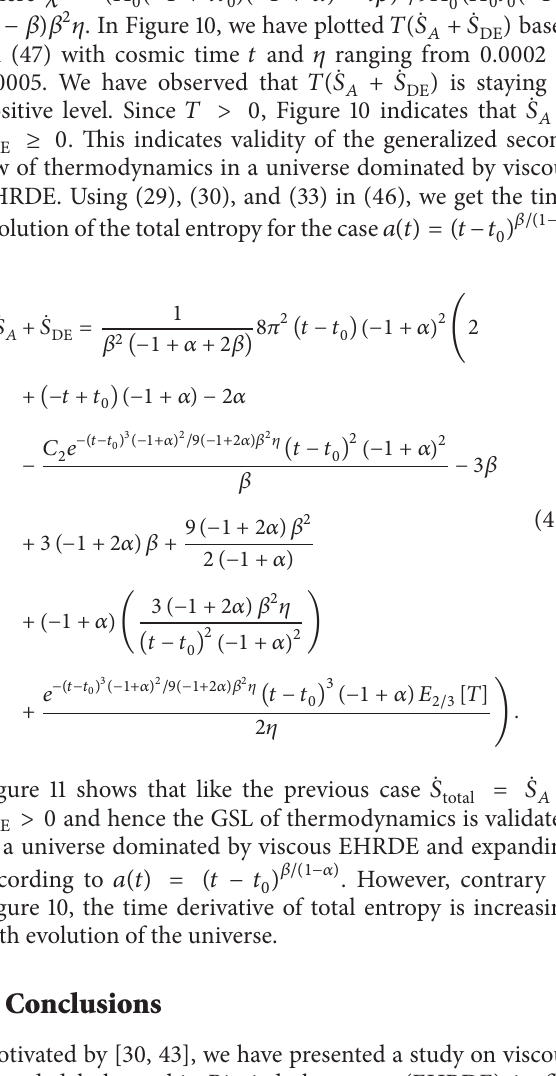
Figure 11: Plot of time evolution of total entropy ( on (47) for 𝑎(𝑡) = (𝑡 − 𝑡 0 ) 𝛽/(1−𝛼) . The {𝛼,𝛽} combination is taken as {0.9180, 0.3701} and 𝜂 ranges from 0.00009 to